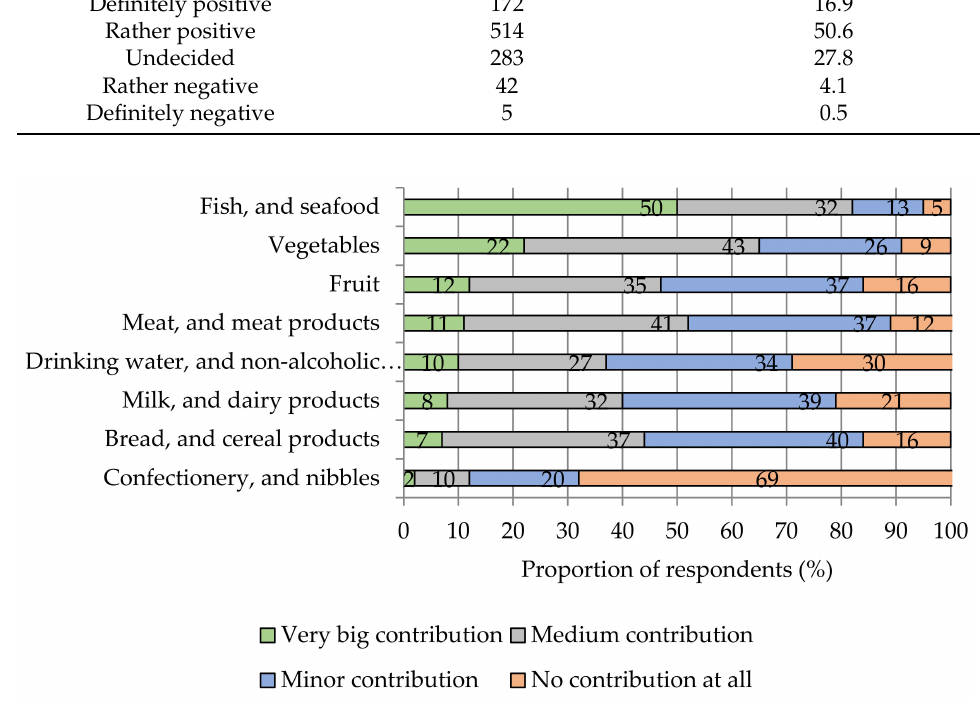
Figure A2. Survey on participants’ assessment of the contribution of different food groups to their personal iodine supply. n =